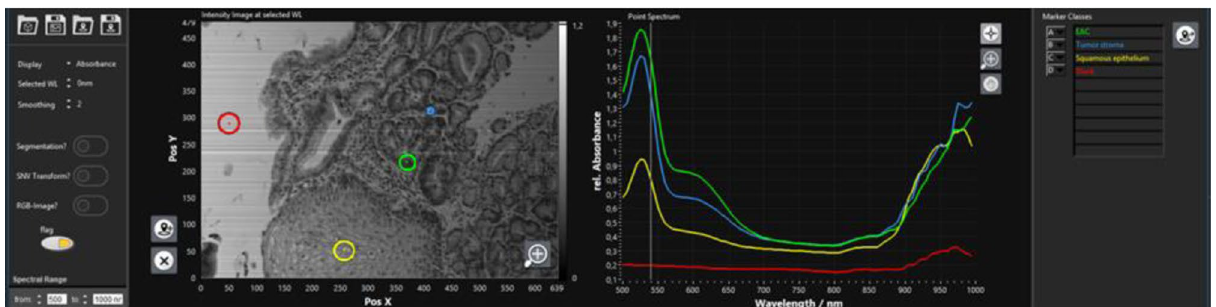
Figure 8. Annotation of EAC and squamous epithelium cells. Annotation was done to specify EAC cells (green), tumor stroma (blue), squamous epithelium (yellow), and blank/background (red). The left panel shows the RGB image provided by the TIVITA software to perform the annotations and the right depicts the corresponding averaged and smoothed spectra. Above wavelengths of 750 nm, the noise in the spectra was very high, which was caused by the lenses inside the microscope (e.g. glasses from lamps,